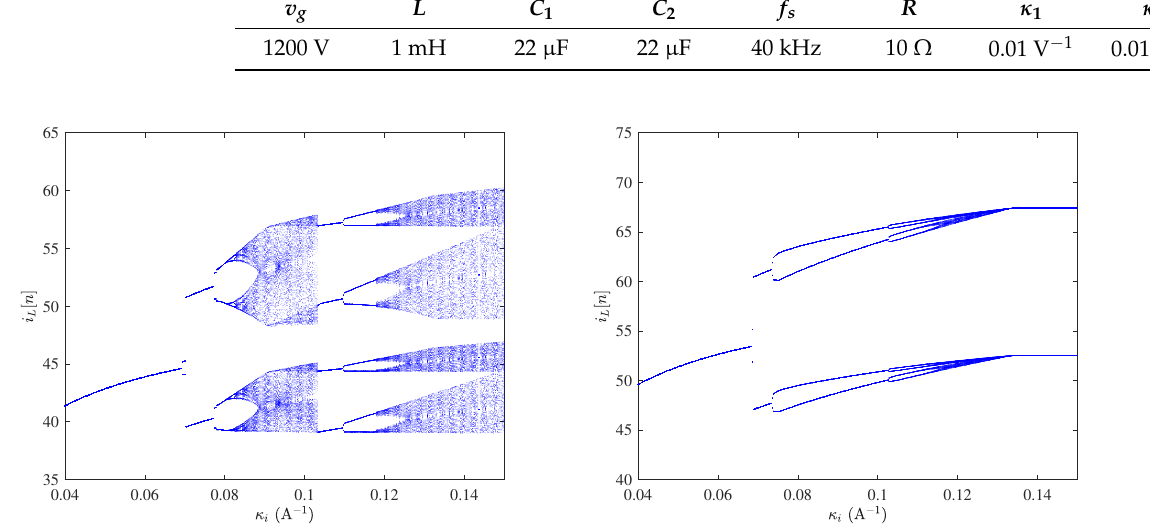
Figure 5. Bifurcation diagrams from the exact switched model implemented in PSIM© software taking κ i as a bifurcation parameter. Left: i ref = 50 A (25 kW). Right: i ref = 80 A (64